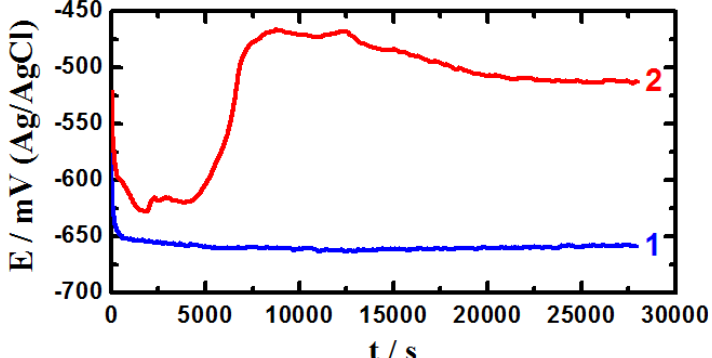
Figure 5. Potential-time curves obtained for (1) pure iron and (2) API X-65 5 L pipeline steel, respectively in 4.0 wt % NaCl